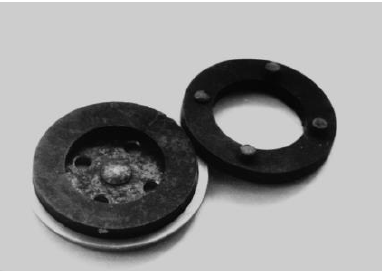
Fig.13. Billets for the thrust of the electric motor of the